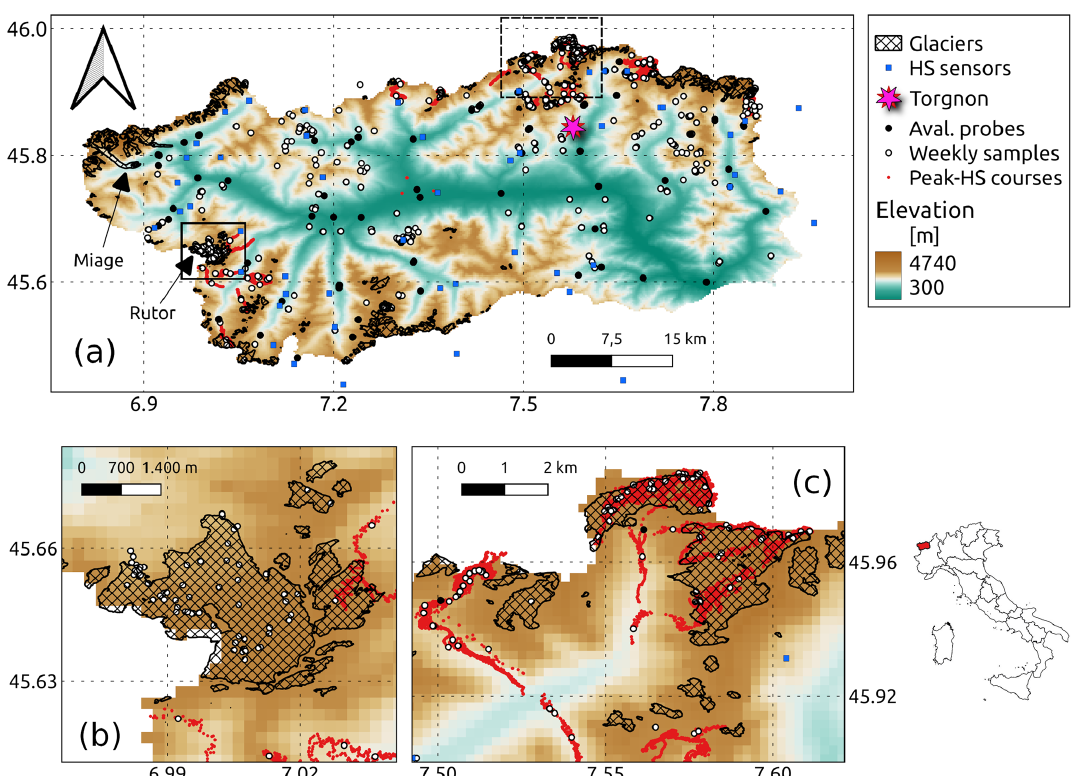
Figure 3. The Aosta Valley in northwestern Italy. (a) Topography and glaciology of this region, with locations of all snow-evaluation data used in this paper. (b, c) Zoom on two intensive measurement regions, the Rutor glacier and the headwaters of the Valpelline catchment, respectively. “HS sensors” are continuous-time snow-depth ultrasonic sensors, “Torgnon” is an intensive study plot with a variety of snow and weather datasets (see Sect. 3.3 and Terzago et al., 2019), “Aval. probes” denotes locations of snow-depth measurements for avalanche forecasting purposes, “Weekly samples” denotes locations of ∼ weekly snow-depth measurements collected mainly for water-supply fore- casting, and “Peak-HS courses” is snow-depth measurements collected along transects of several kilometers for hydropower-forecasting purposes (see Avanzi et al., 2021, for more details). Panel (a) includes the locations of the Miage and Rutor glaciers, for which detailed evaluation results are reported in Sect.